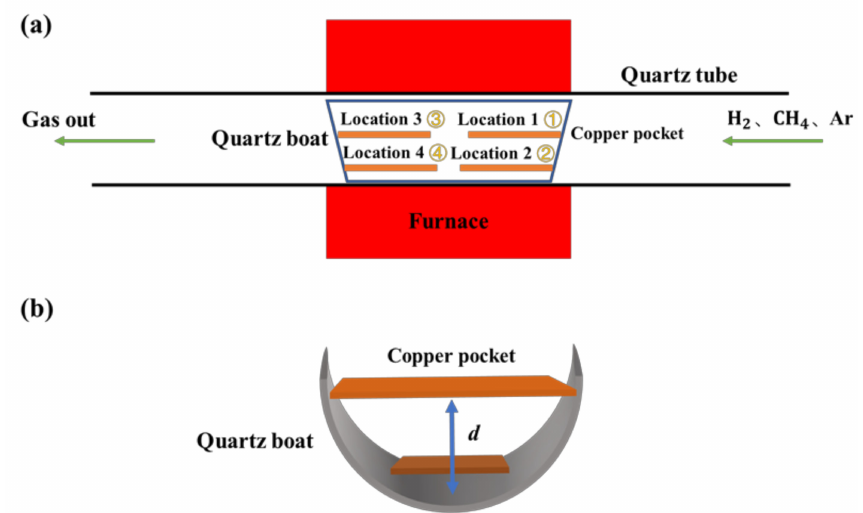
Figure 1. ( a ) Schematic illustrations of the distribution of four regions in the quartz boat in the transverse direction and the CVD system. ( b ) Schematic illustrations of the copper pockets placed in the quartz